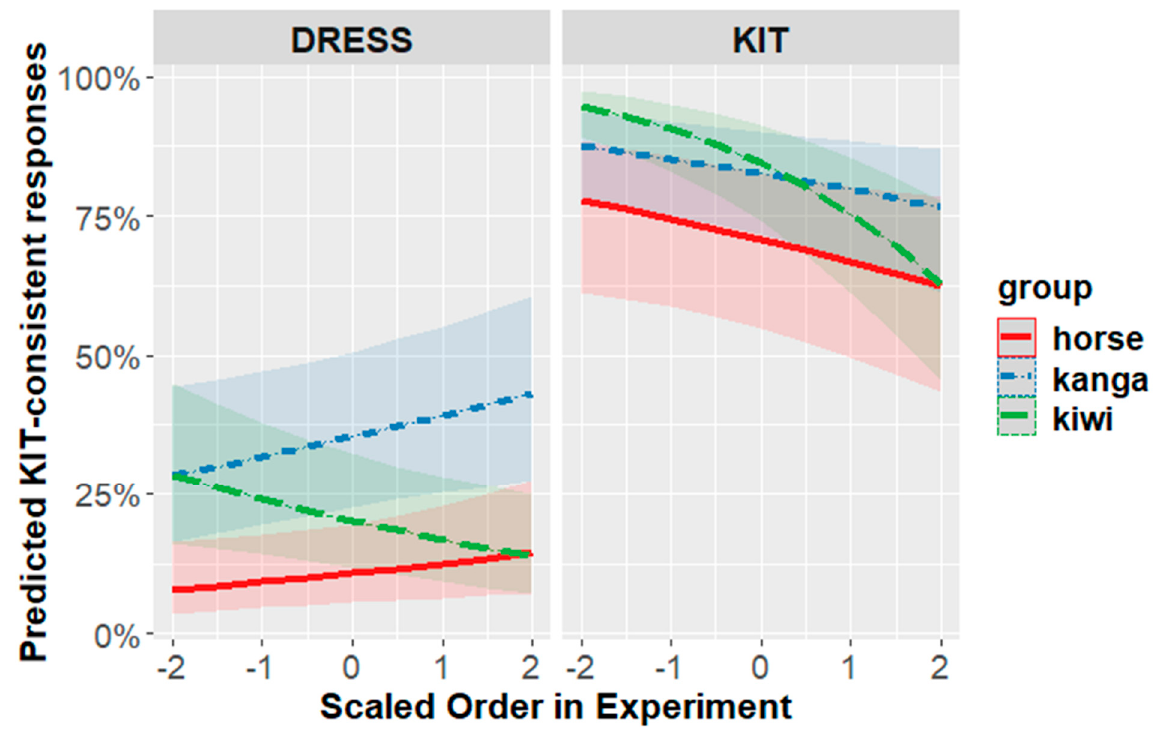
Figure 7. Model prediction plot from the model fit to men only (model details in supplementary materials). The figure plots a set of 3 two-way interactions involving order (x-axis), prime-type (lines), and frame (panels).